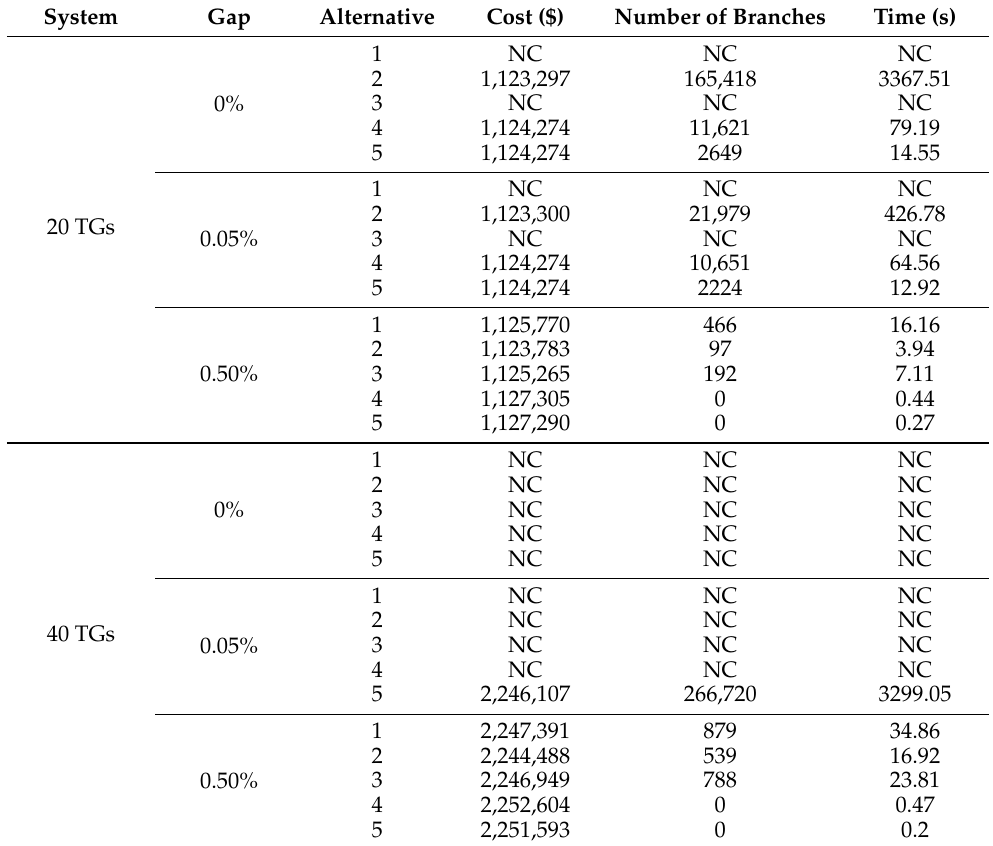
Table 11. Optimization results for 20 and 40 TGs.